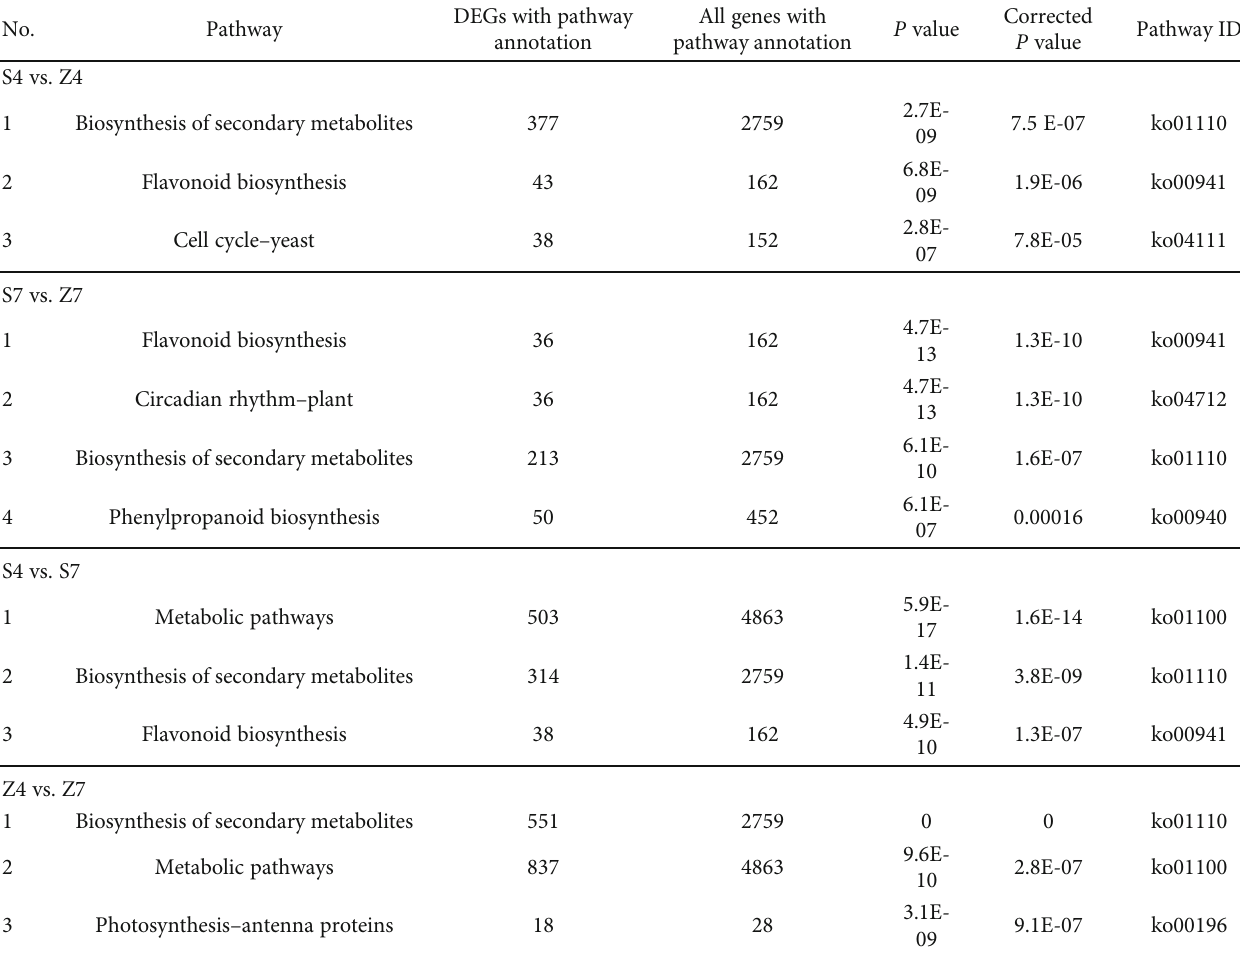
Table 1: Signi fi cantly enriched KEGG pathways between Shanhua15 and Zhonghua12 peanuts testa.